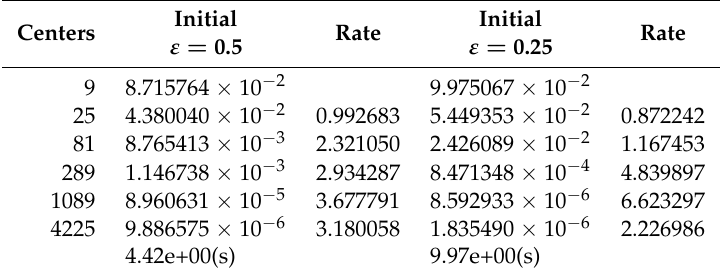
Table 4. Hierarchical radial basis function (H-RBF) interpolation.